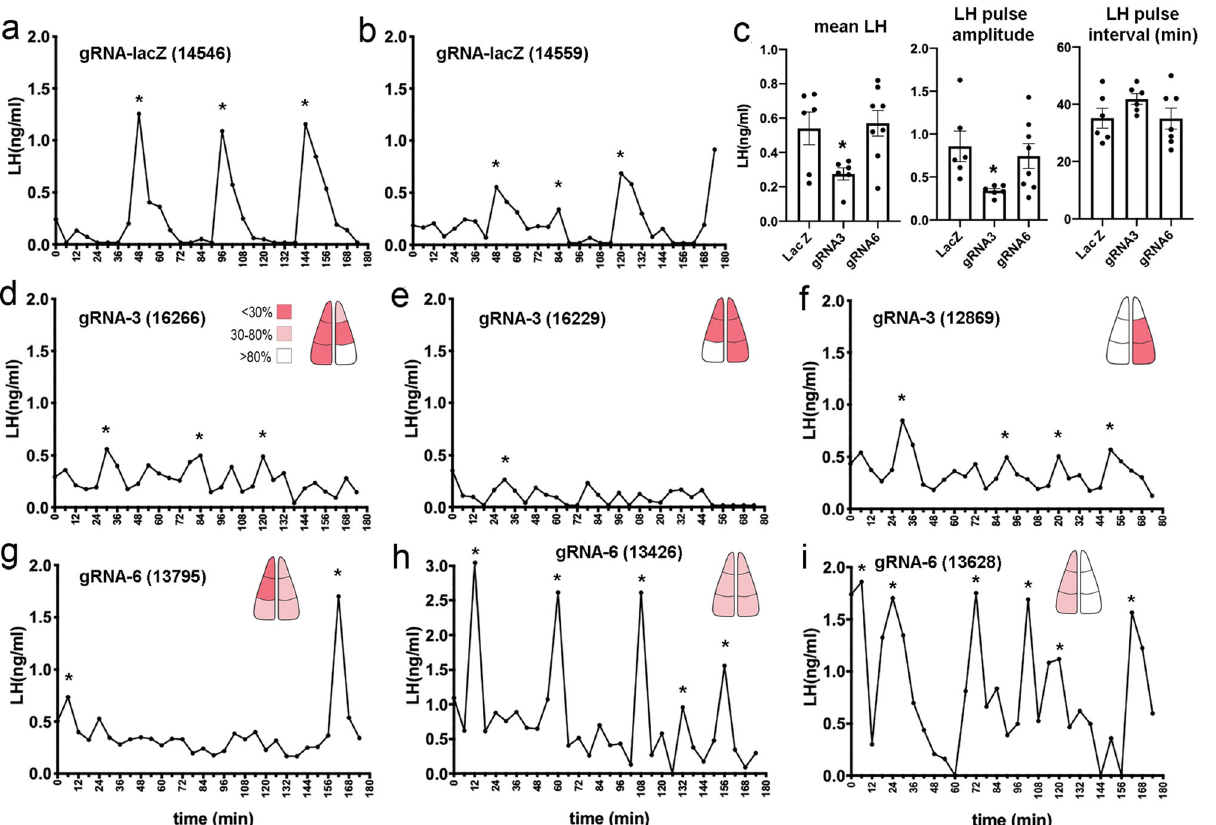
Fig. 6 | Effects on pulsatile LH secretion of CRISPR-Cas9 knockdown of ESR1 expression in adult ARN KISS neurons. a , b Examples of LH pulse pro fi les in Kiss1- Cre,LSL-Cas9-EGFP mice given gRNA-LacZ. Numbers in brackets refer to animal number.AsterisksindicateLHpulses. c Mean±SEMLHlevels,pulseamplitudesand pulse intervals in the experimental groups receiving gRNA-LacZ (LacZ, N =6), gRNA-ESR1-3 (gRNA3, N =6), and gRNA-ESR1-6 (gRNA6, N =8). * P ≤ 0.05, post hoc Dunnett ’ s test versus LacZ. A pulse interval of 156min (see G.) is not shown